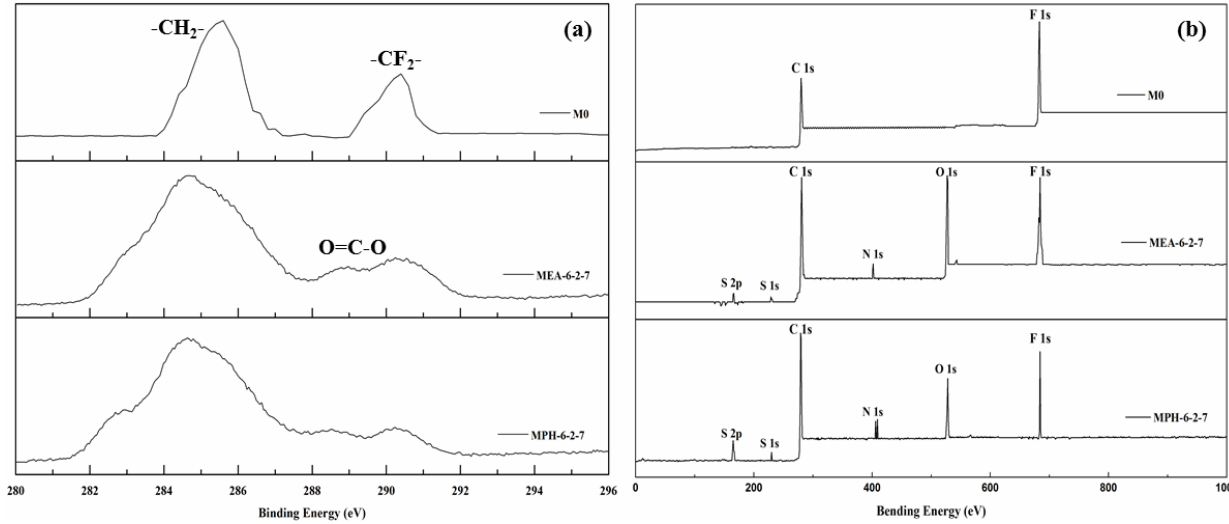
Figure 2. XPS C 1s core-level spectra ( a ) and XPS spectra ( b ) of various